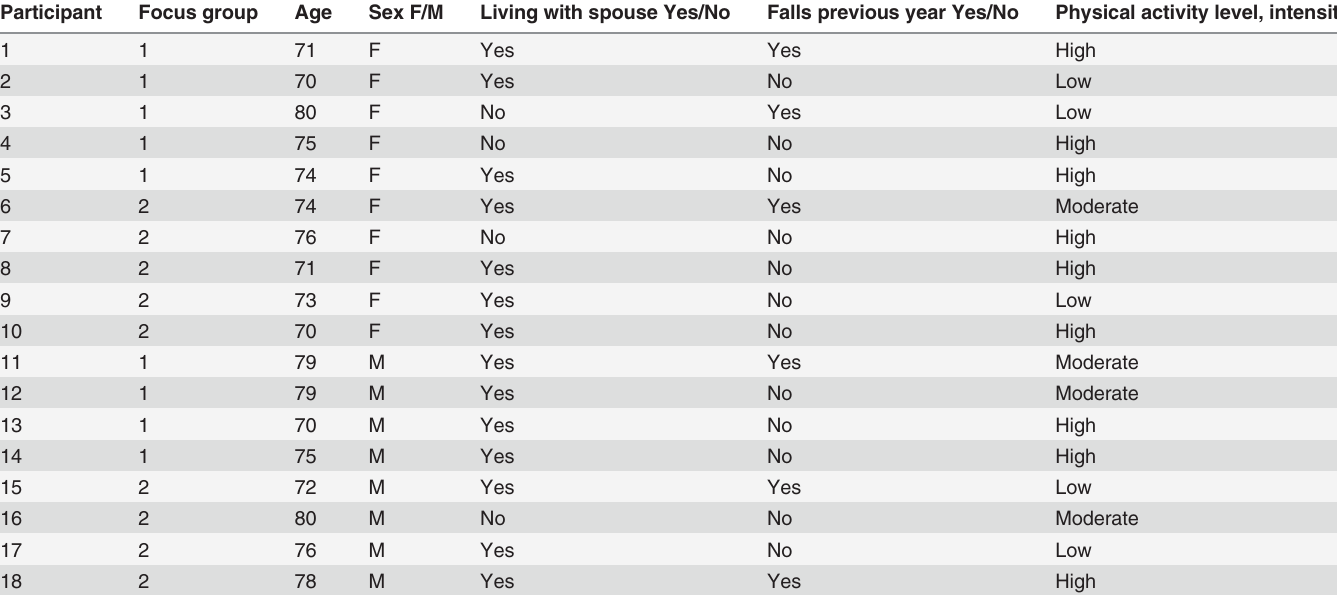
Table 1. Background information on the 18 participants.